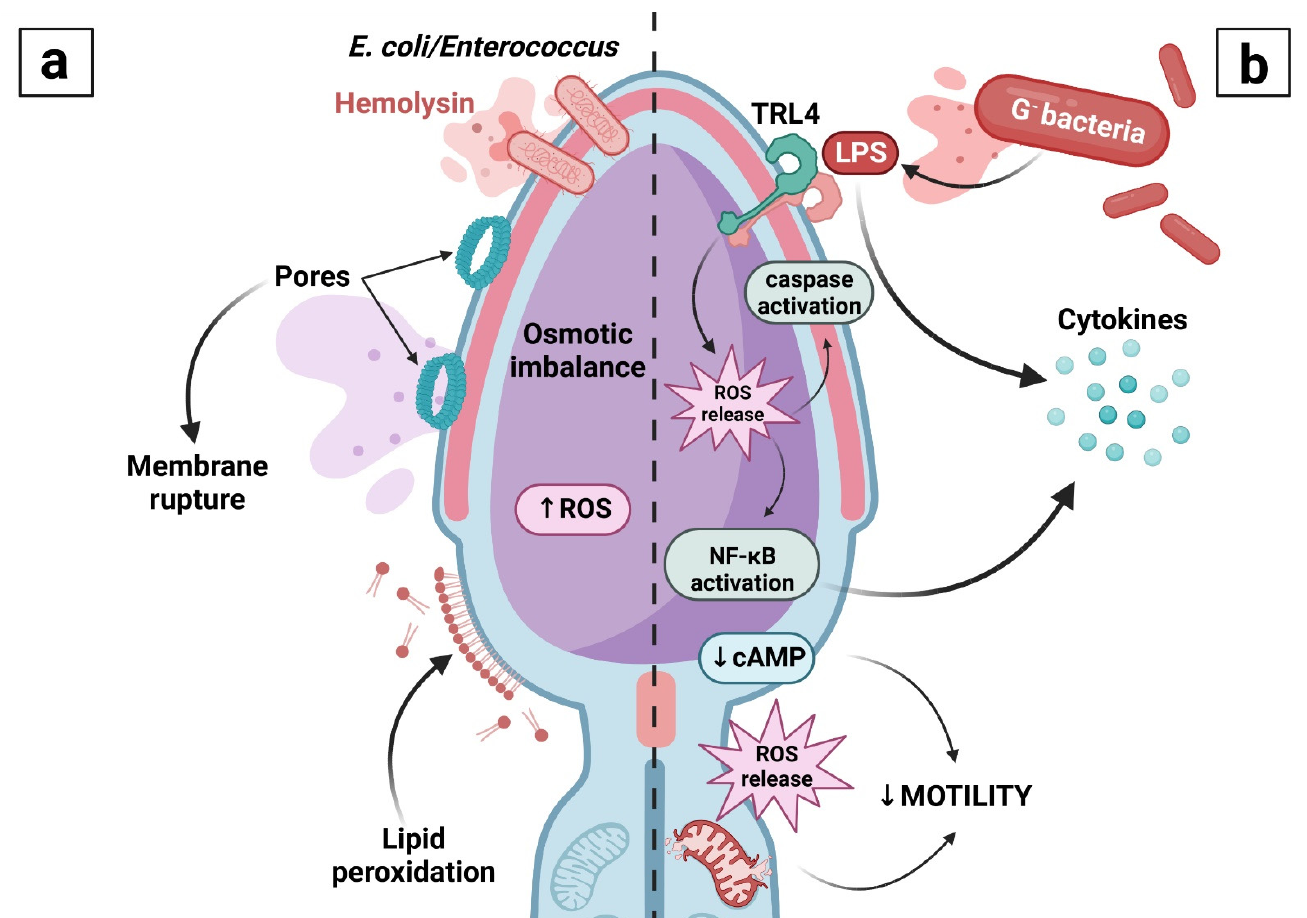
Figure 3. Damage to the sperm cell caused by ( a ) hemolysins or ( b ) lipopolysaccharide